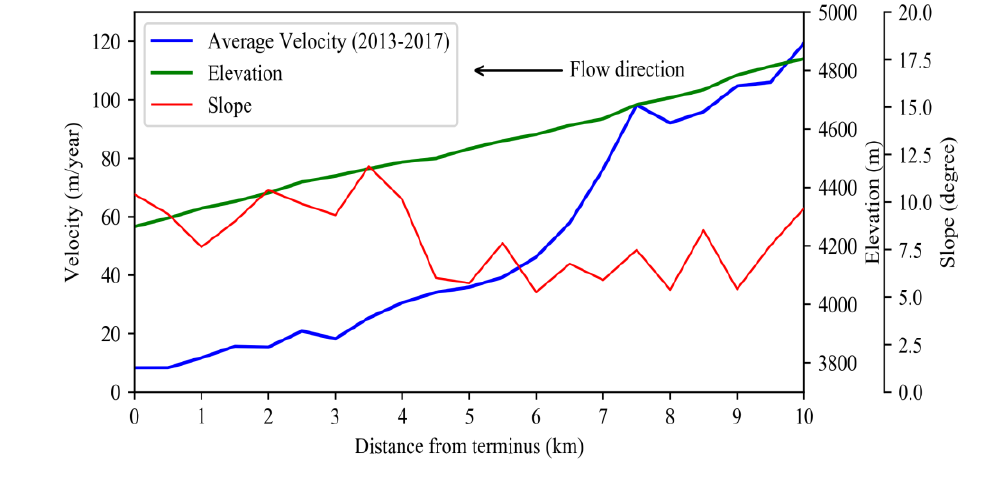
Figure 4. Annual surface velocity of Samudra Tapu Glacier during 2013-2017